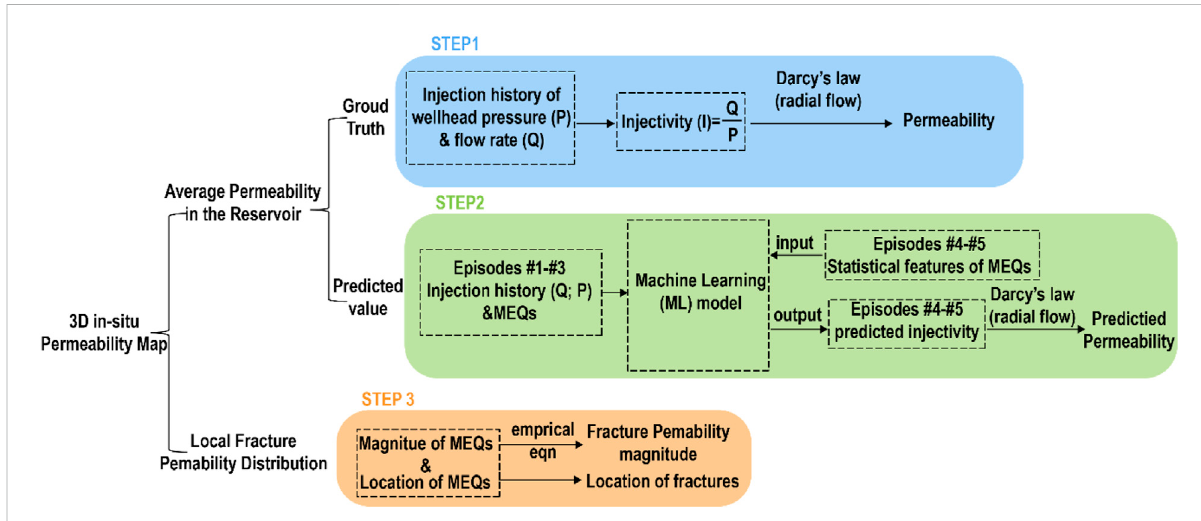
FIGURE 1 Logic chart and steps to create mean permeabilities and a permeability map.